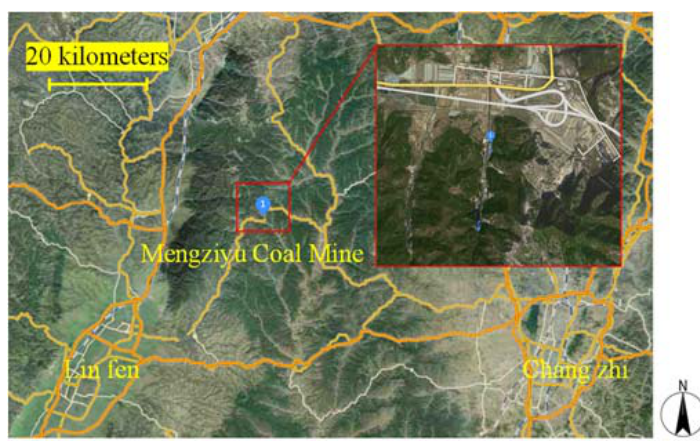
Figure 2. Mengziyu coal mine.